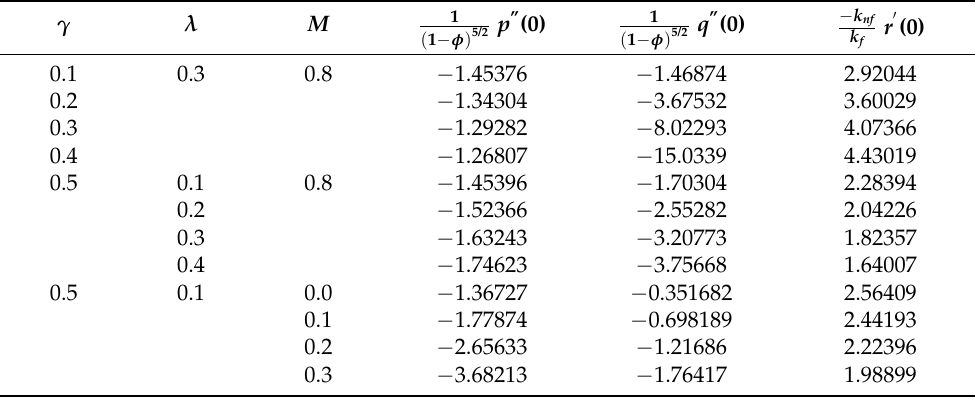
Table 4. Impacts of different constraints on skin friction